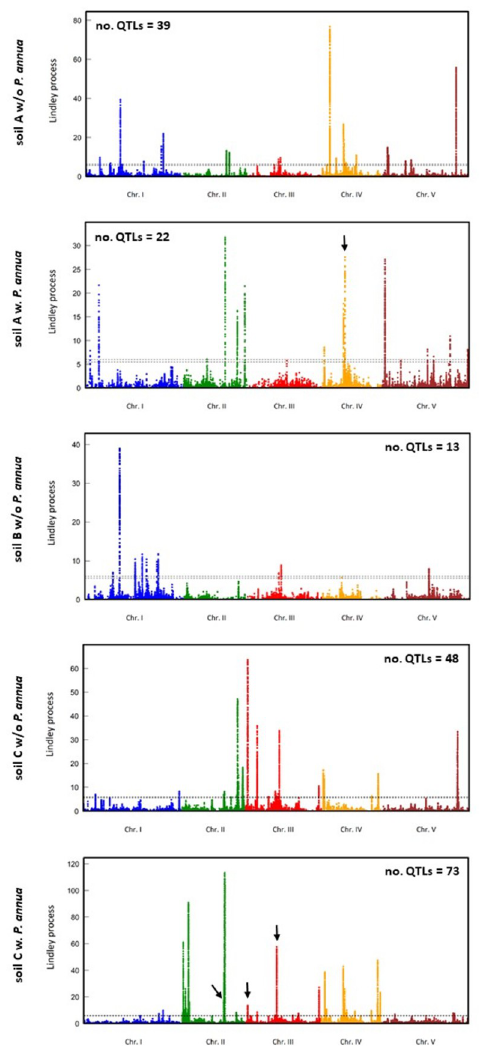
Fig 4. A polygenic architecture underlying natural genetic variation in disease index within each micro-habitat for which disease index was significantly heritable. Manhattan plot of the Lindley process (local score method with a tuning parameter ξ = 2). The x-axis indicates the physical position of the 981,617 SNPs with a minor allele relative frequency above 7%, along the five chromosomes. The dashed lines indicate the minimum and maximum of the five chromosome-wide significance thresholds. Black arrows indicate the positions of the four QTLs containing candidate genes common between disease index and total seed production (see Fig